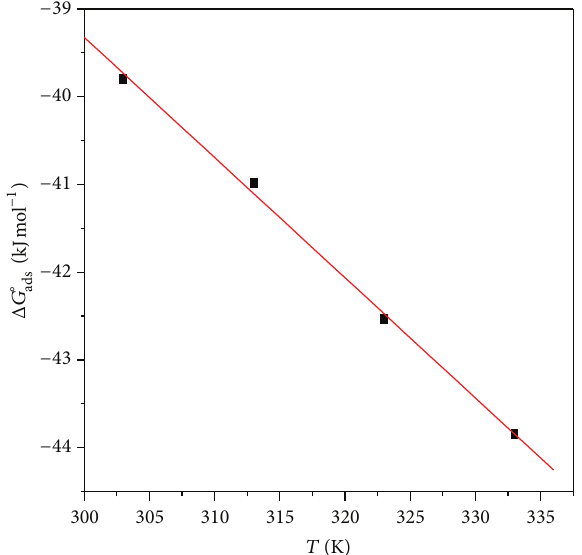
Figure 8: Plot of Δ𝐺 ∘ versus temperature for the adsorption of ads HIBH on mild steel in 1M